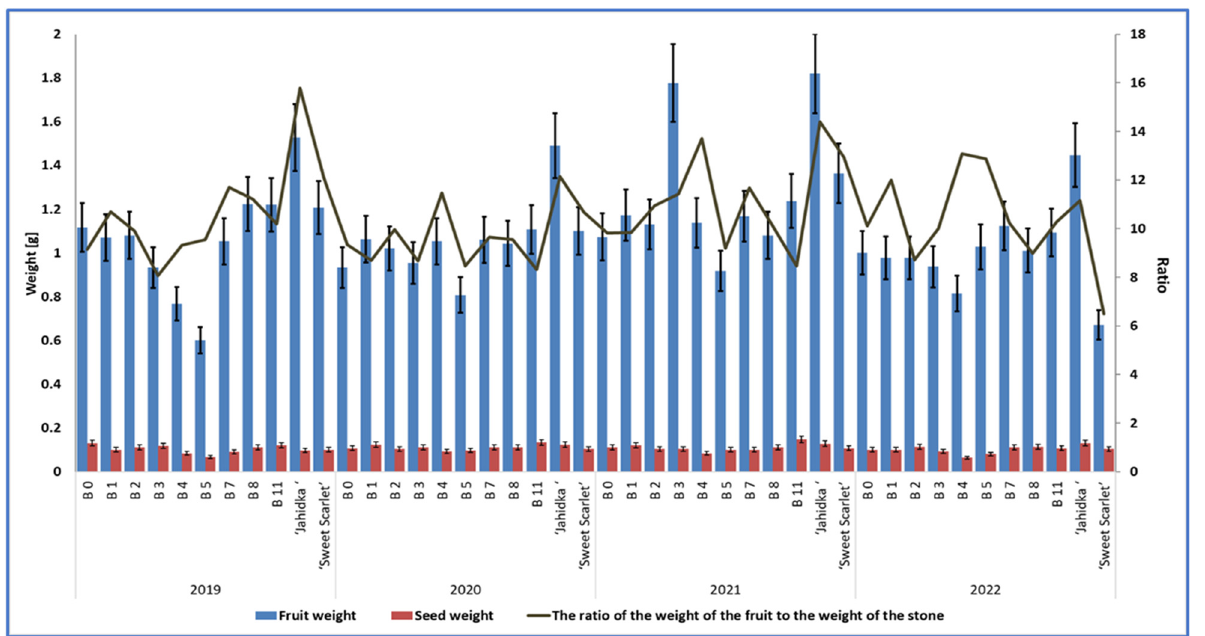
Figure 7. The mean weights of fruits and seeds and the fruit-to-seed weight ratios of 9 biotypes and cultivars of E. multiflora in 2019–2022.